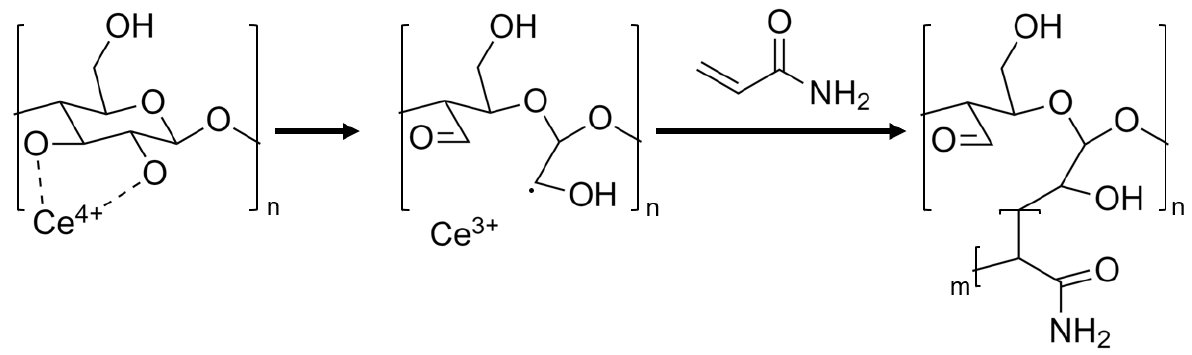
Figure 1. Proposed mechanism of cerium-initiated copolymerization of cellulose and acrylamide